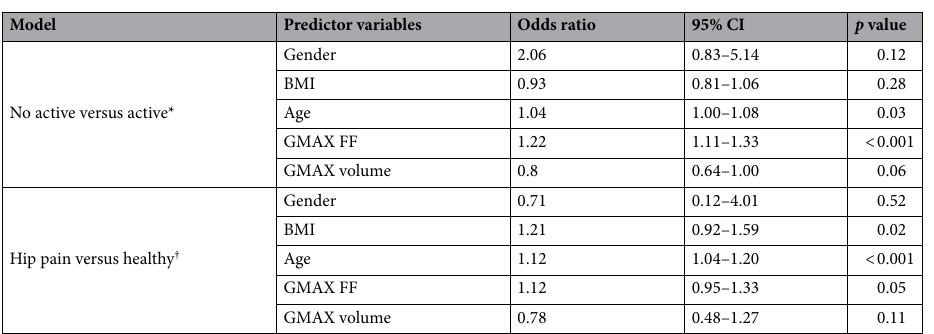
Table 4. Results of a hierarchical logistic regression analysis of variables associated with being physically inactive and with hip pain. The first model estimates the odds of being physically not active or active for each variable, while the second the odds of having hip pain or a healthy hip. The odds ratios, 95% confidence intervals and p values are reported. *(Pain + low activity) versus (medium + high activity). † (Pain) versus (low + medium + high